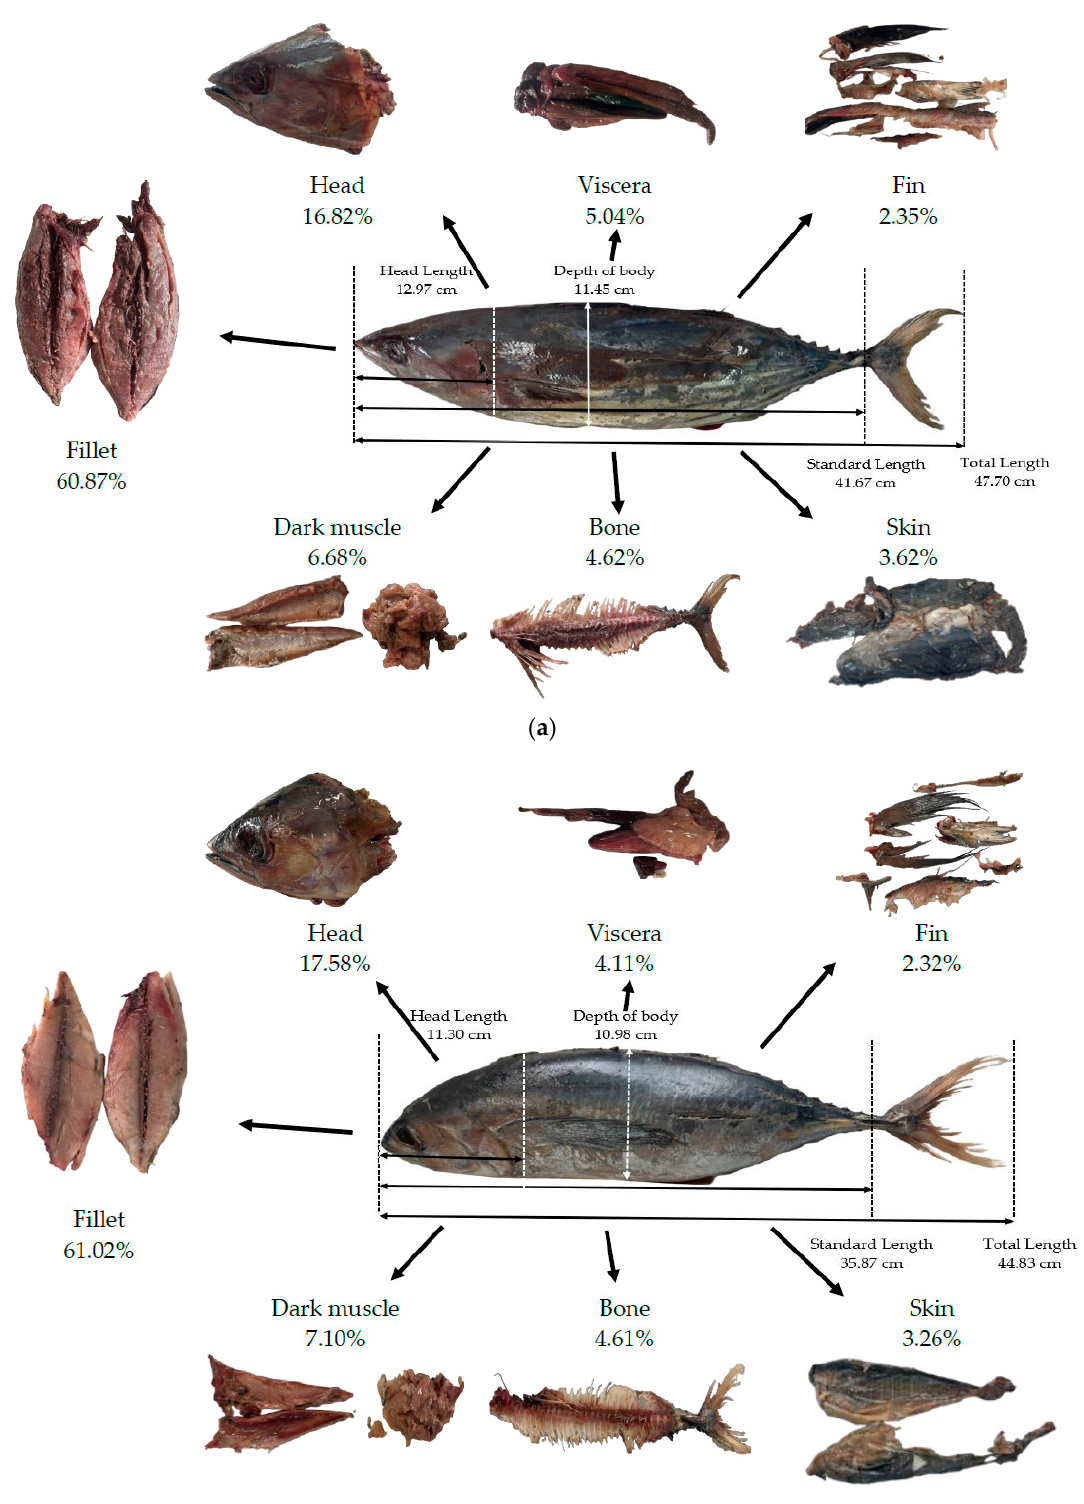
Figure 1. Fish length measurement (total length, standard length, head length, and depth of body) and components of tuna processing by-products by percentage of total fish weight: ( a ) skipjack tuna ( Katsuwonus pelamis ); ( b ) yellowfin tuna ( Thunnus albacares ).